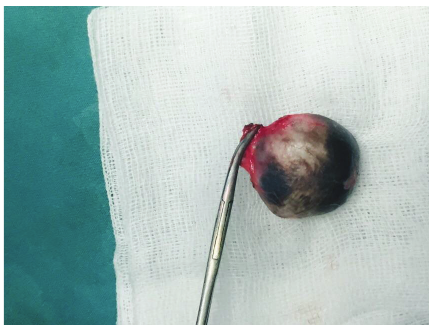
Figure 2: Postoperative image of the cyst after removal (filled with off-white granulose keratinous